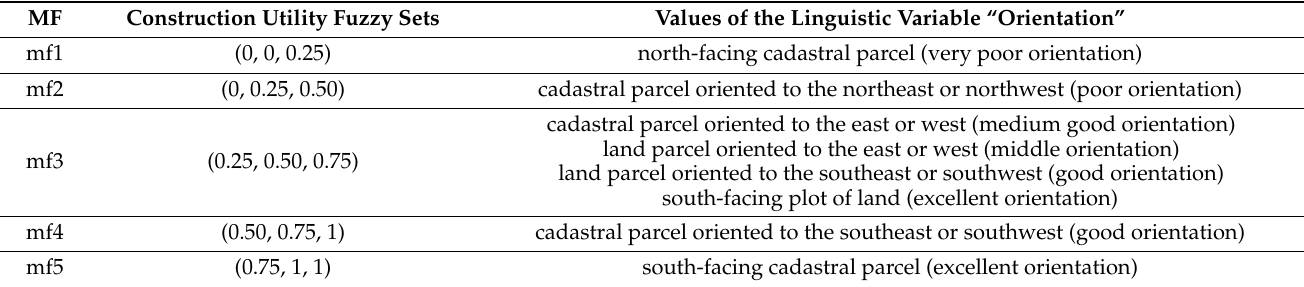
Table 5. Defining fuzzy sets and values of the linguistic variable